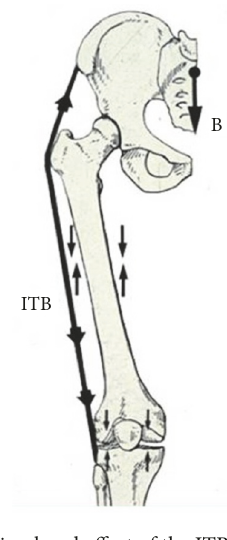
Figure 4: Compression band effect of the ITB. As a “tension band” lateral to the femur, the ITB neutralizes tensile loads and creates compression loading along the lateral aspect of the femur during unilateral stance phase of gait. This explains the presence and distribution of cortical bone in the lateral femur and is consistent with Wolff’s